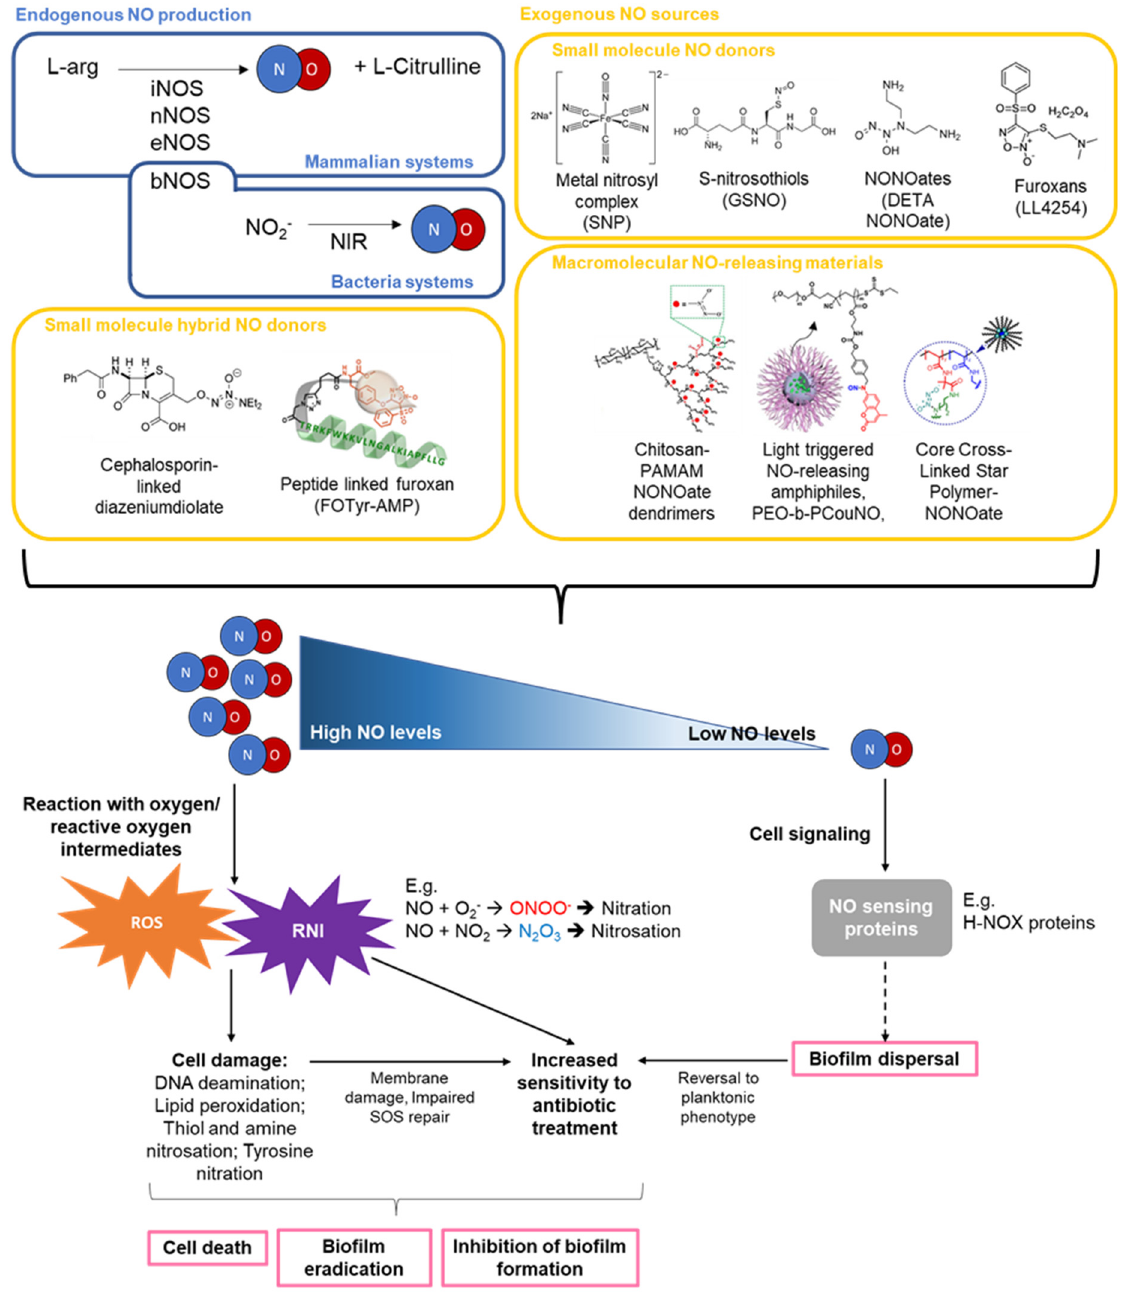
Figure 1. Examples of commonly used NO-donors, hybrid and macromolecular NO-releasing designs [21–26]NO at various concentrations can exert antimicrobial effects and/or potentiate the activity of antimicrobials Similar to mammalian systems, the activity of NO on bacteria and bacterial biofilms is dependent on its local concentration. In bacteria, NO may be generated from L-arginine by bacterial NOS [27– 29]. Alternatively, NO may be produced through NOS-independent pathways, such as the reduc- tion in nitrite to NO by nitrite reductases in denitrifying bacteria [30]. In general, at low concentra- tions (pM–µM), NO can mediate biofilm formation or disperse biofilms, while at higher concentra- tions (>1 mM), NO exerts a bactericidal effect in a similar manner as described above for mammalian cells. The effects of targeted or spontaneous release of high and low doses of NO can be found in